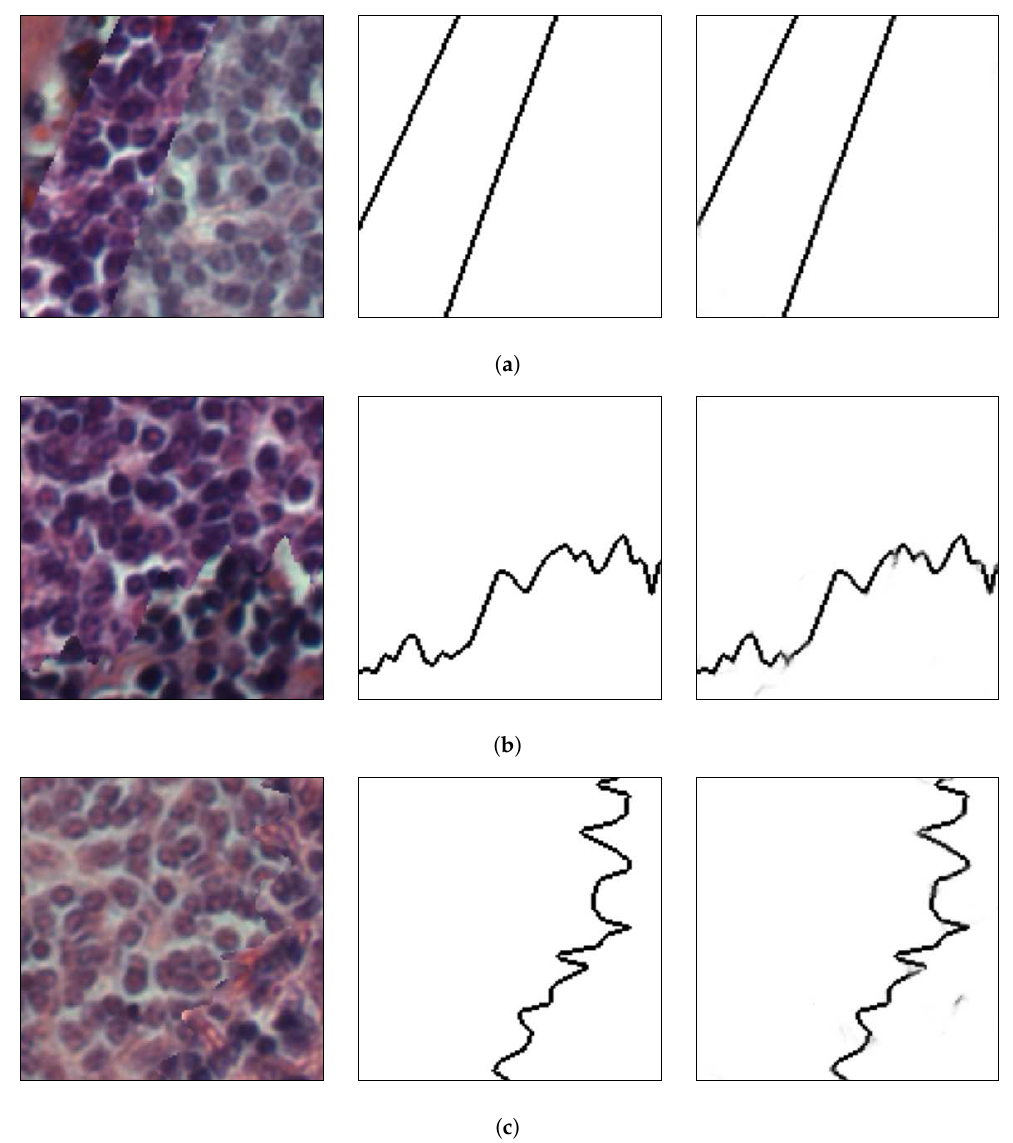
Figure 20. Application on lymphoma tissue images. From left to right, respectively: original image; ground-truth; and the results on the proposed method. Letters ( a – c ) present different mosaic images and are used for referencing the images in the